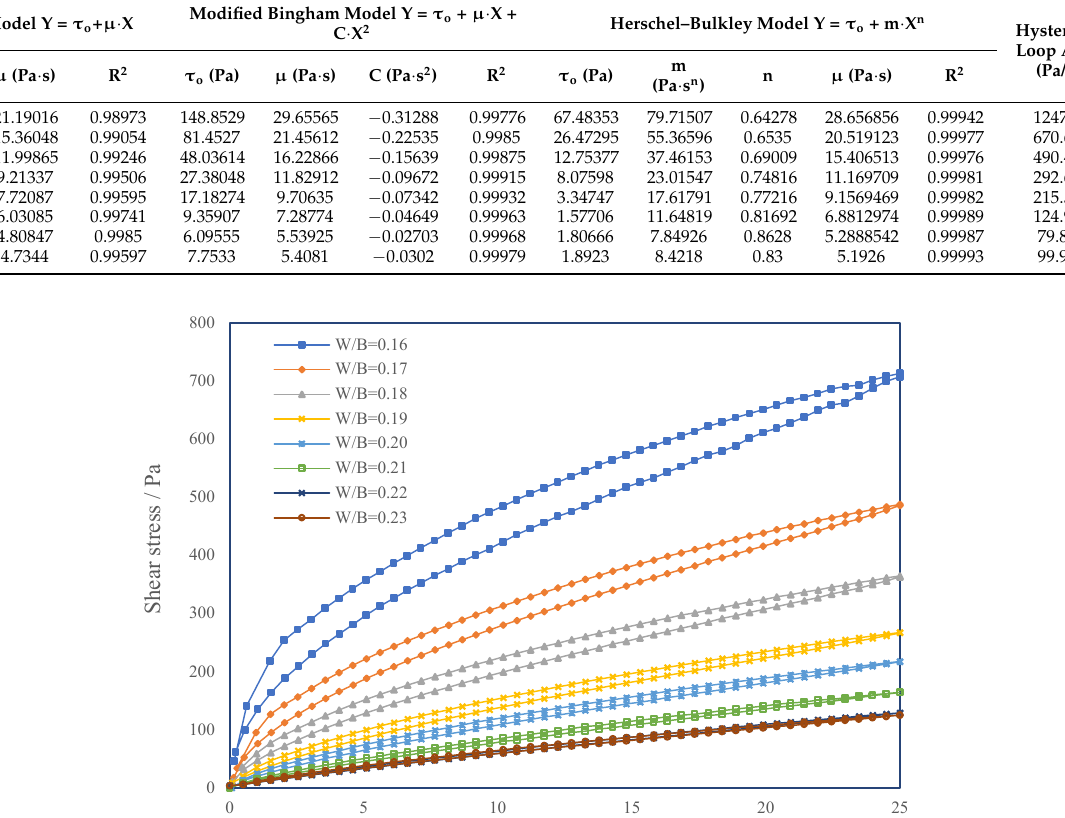
Table 4. Rheological parameters of CSHWMs with different W/B ratios.